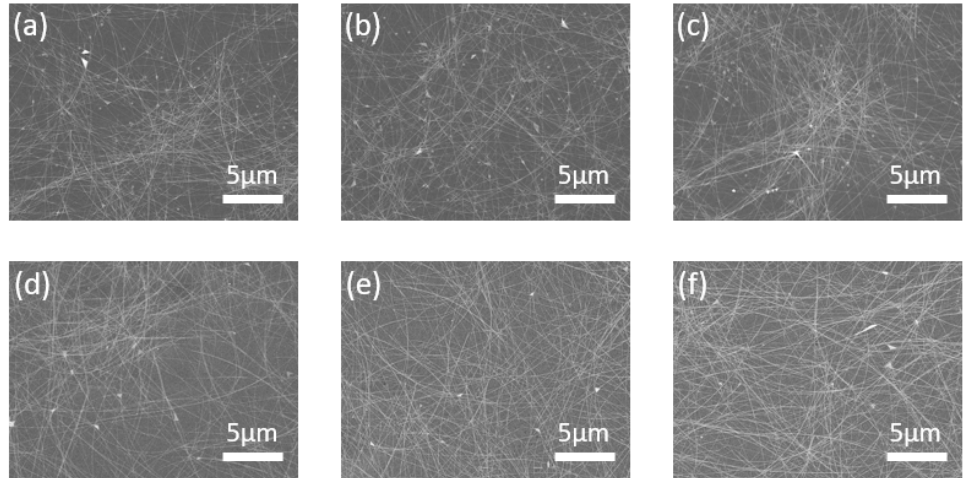
Figure 2. Scanning electron microscopy (SEM) images of ( a – c ) the AgNW-exposed electrodes and ( d – f ) AgNW-embedded electrodes with different drying methods: ( a , d ) thermal drying at 120 °C for 1 min, ( b , e ) room-temperature drying for 30 min, and ( c , f ) vacuum drying for 30 min.